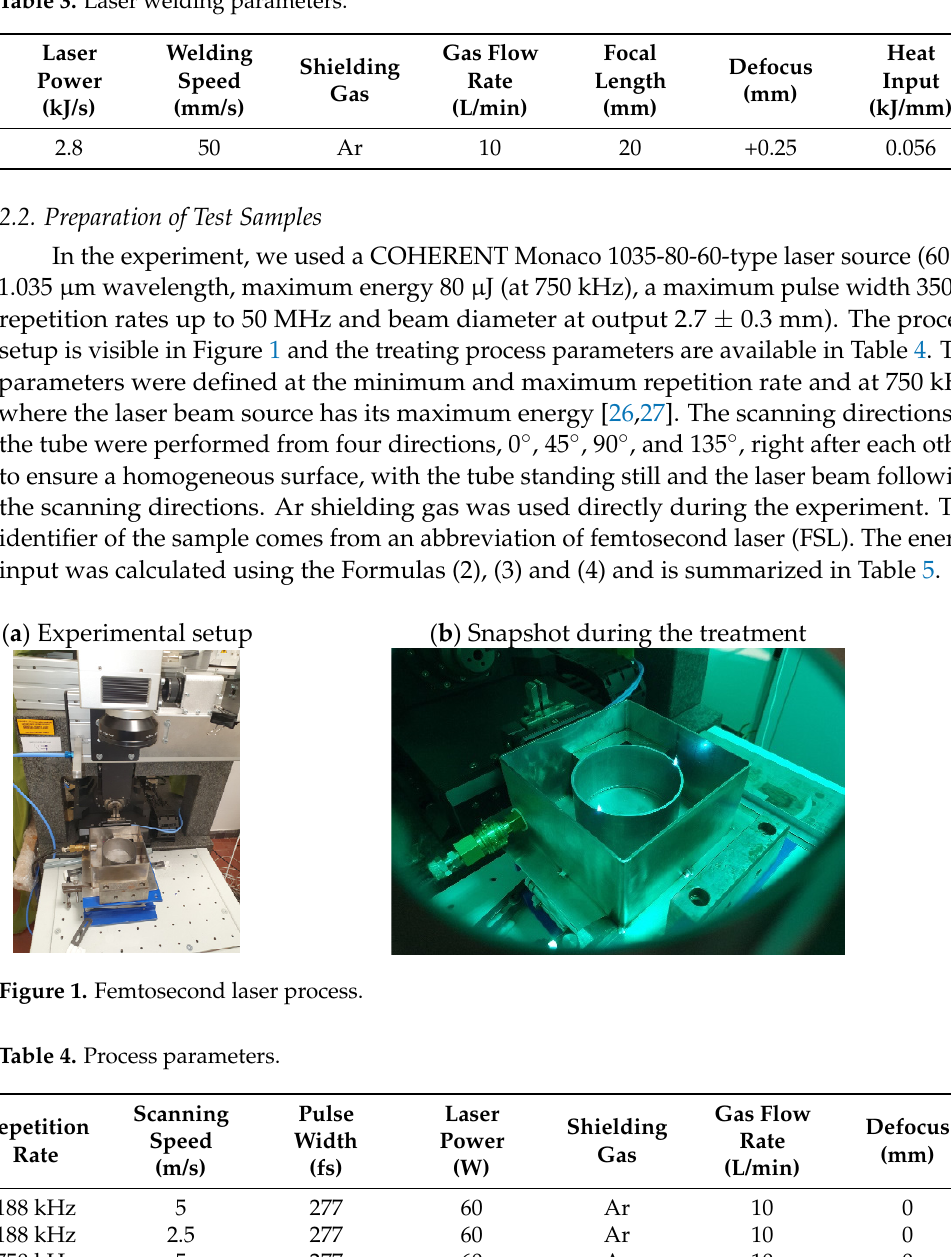
Table 3. Laser welding parameters.